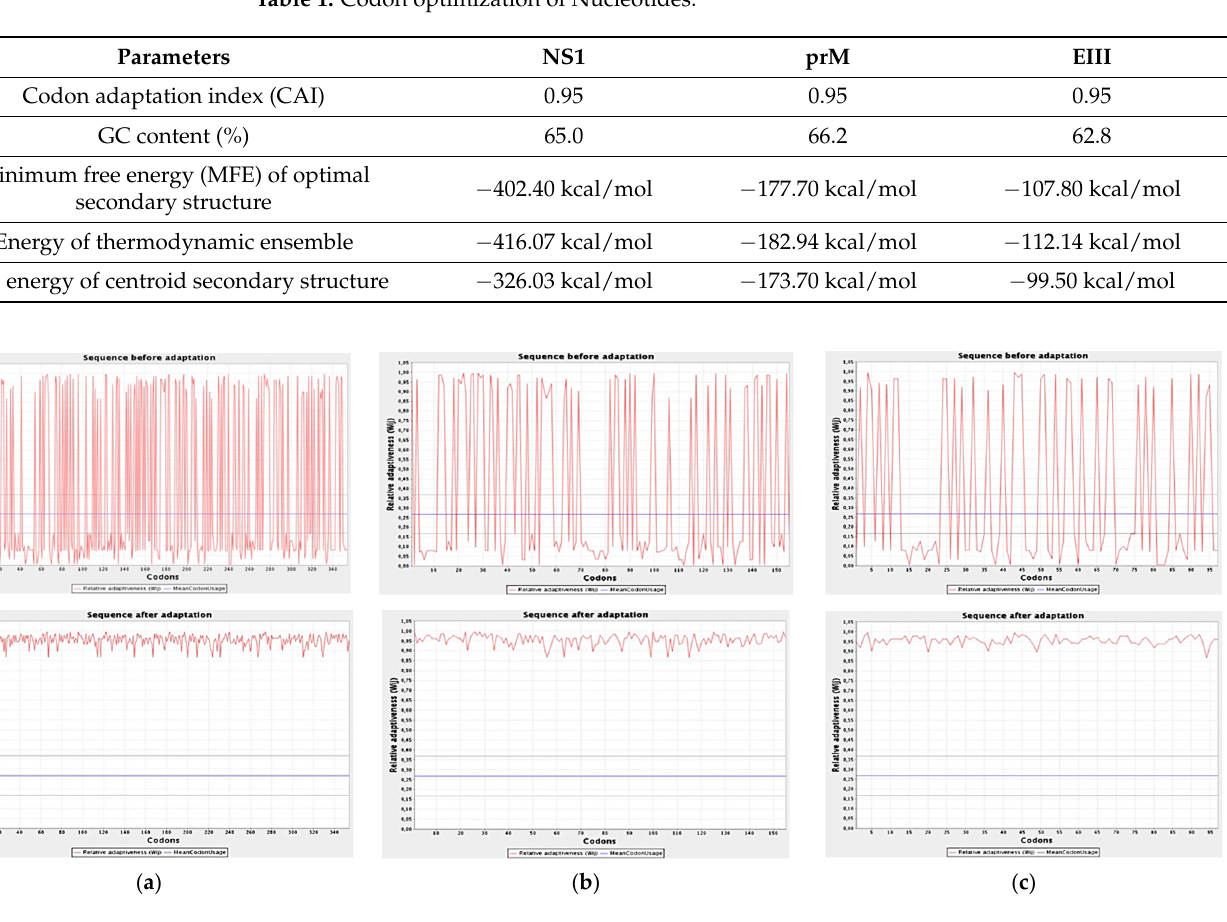
Figure 1. CAI value before optimization (above) and after optimization (below). ( a ) CAI of NS1 improved from 0.1 to 0.95, indicating good expressive state of codons; ( b ) CAI value of prM improved from 0 to 1, indicating the best expressive state of codons; ( c ) CAI value of EIII improved from 0.1 to 0.95, showing good expressive state of codons.